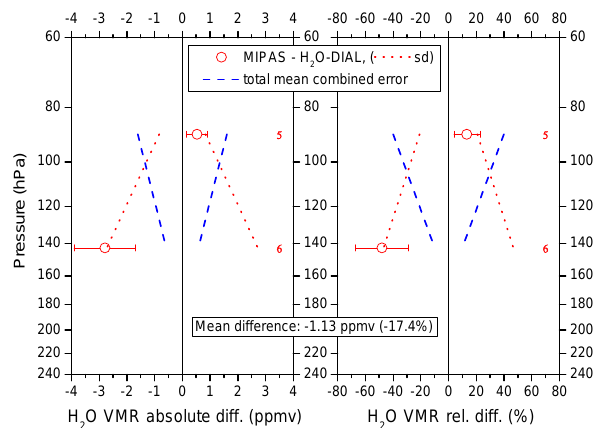
Fig. 11. Mean differences of all comparisons between MIPAS and smoothed H 2 O-DIAL observations (red circles) together with mean combined total errors (blue dashed lines) as well as standard deviation (red dotted lines) and the standard error of the mean, plotted as error bars. Red values indicate the number of collocations.